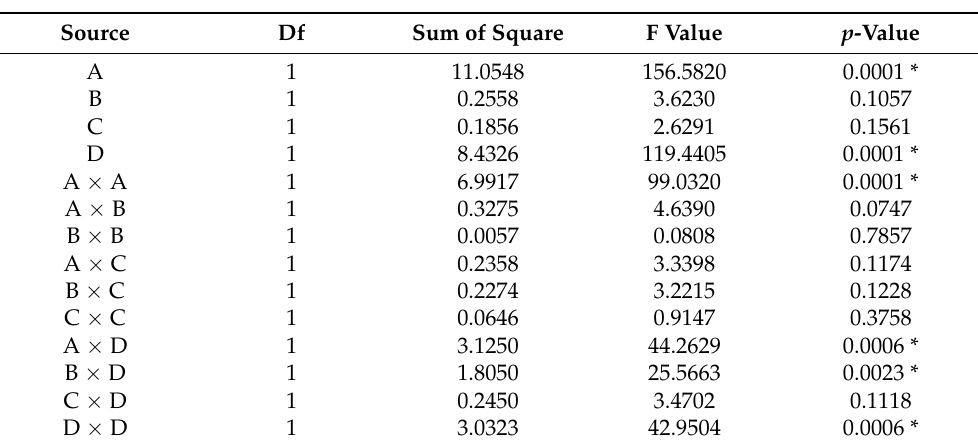
Table 4. Significance test for the regression coefficients. Df Sum of